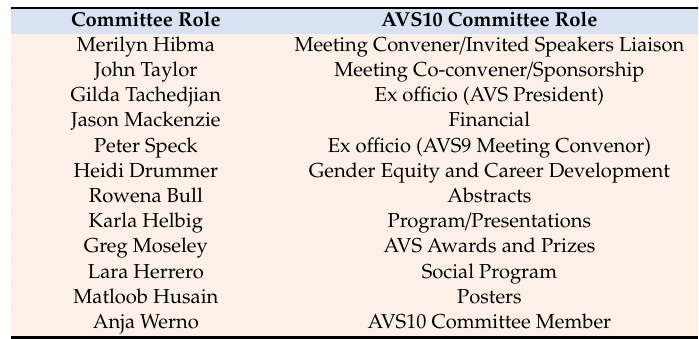
Table 3. AVS10 Organising Committee.